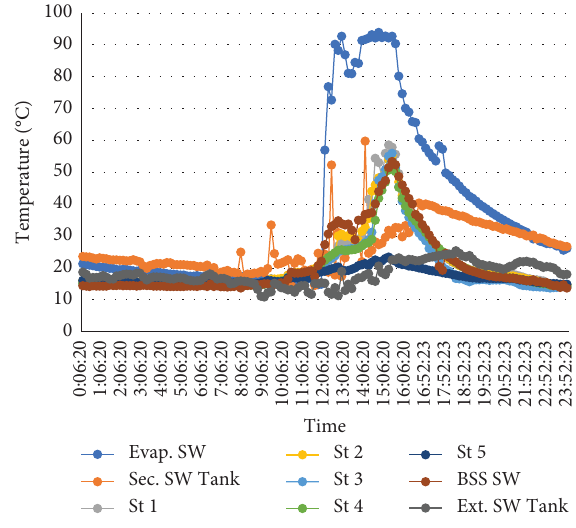
Figure 7: SW temperature curves for the 29 th of May